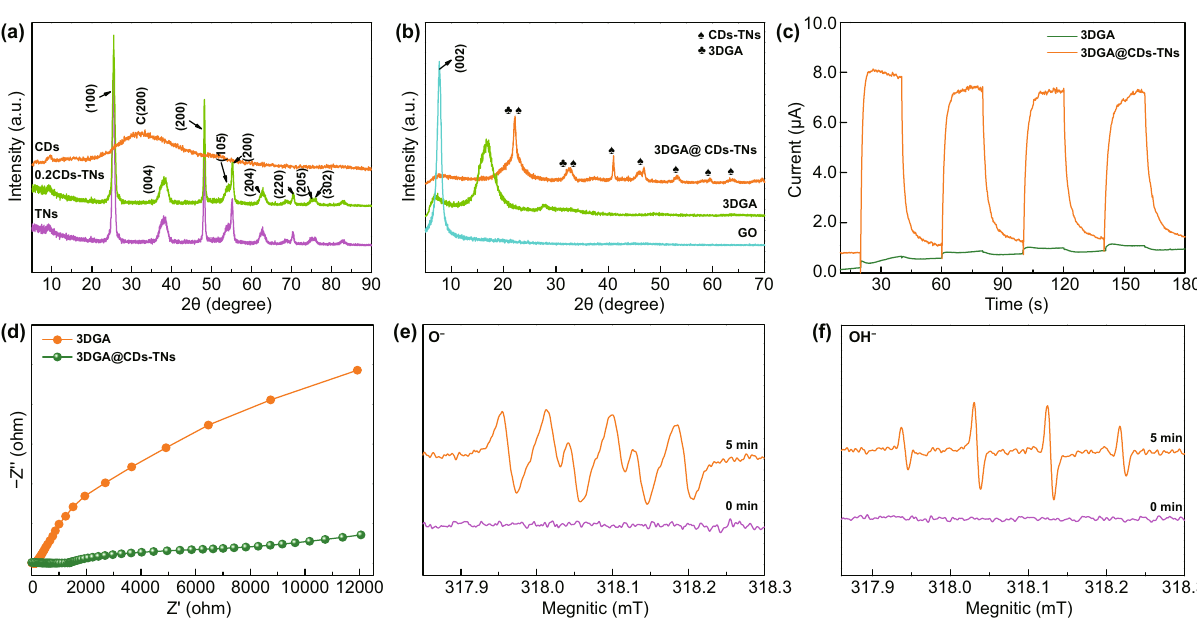
Fig. 3 XRD patterns of samples: a CDs, TNs, and CDs-TNs, b GO, 3DGA, and 3DGA@CDs-TNs photocatalyst. c EIS curves and d tran- sient photocurrent densities for 3DGA@CDs-TNs photocatalyst under intermittent visible light irradiation. ESR spin-trapping profiles for e DMOP- ⋅ O 2− and f ⋅ OH generation over 3DGA@CDs-TNs